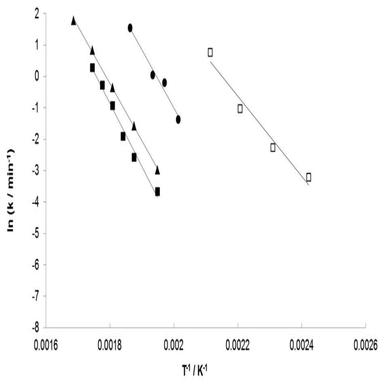
Arrhenius plots for the selected ILs: , j, h, ▲.